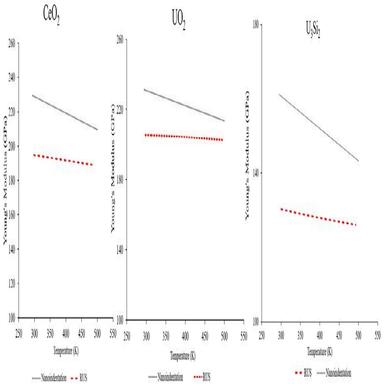
(A) The temperature-dependent Young's moduli measured using nanoindentation and RUS of (A) CeO2, (B) UO2, and (C) U3Si2. The Young's moduli for the nanoindentation is a fit of the data.